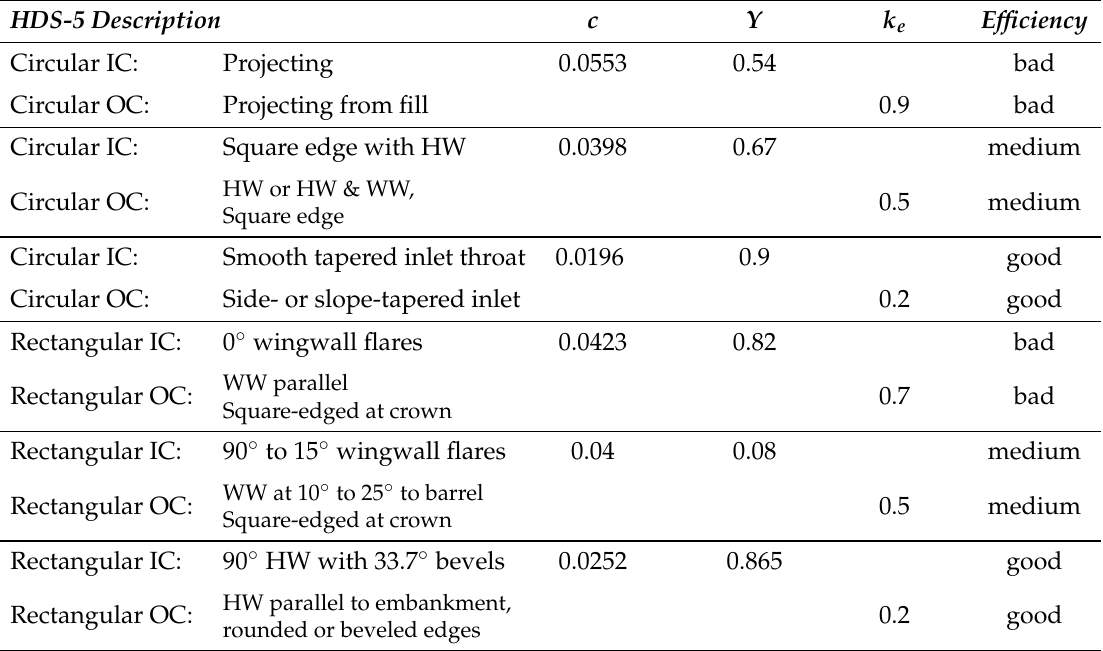
Figure 4. Comparison of different inlet configurations for ( a ) circular and ( b ) rectangular culverts Table 3. Entrance loss coefficients for modeled culverts. These coefficients were used to compare different inlet designs under the two different flow controls. The inlet control equation contains two variables ( c & Y ) to describe the head losses, the outlet control equation uses just one ( k e ); HW = headwall, WW =